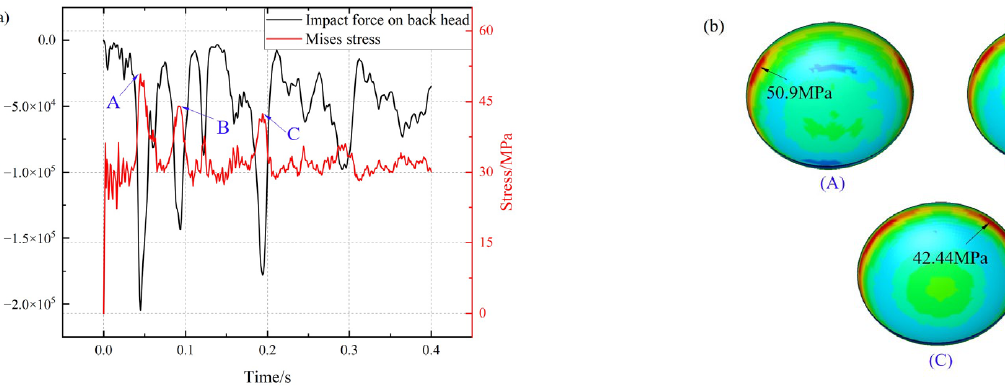
Figure 20. The variation of the maximum Mises stress at the back head over time: ( a ) relationship with the LNG impact force; ( b ) location of three peak stresses.